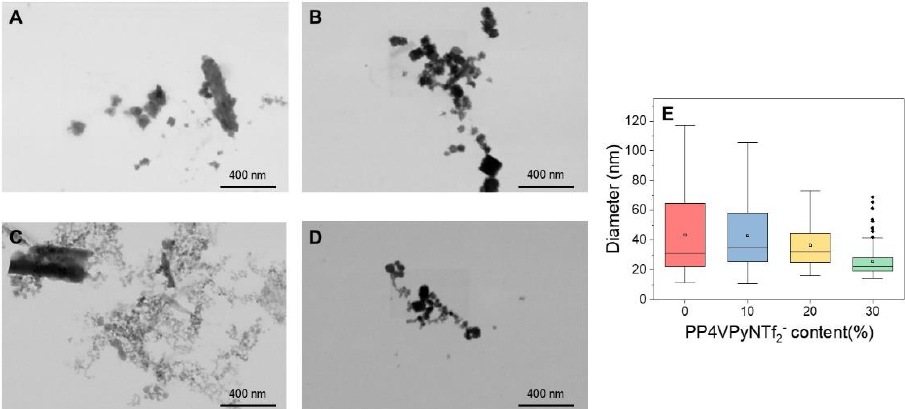
Figure 8. FE-SEM images of synthesized gold nanoparticles in ( A ) P4VPy, and P4VPy/PP4VPyNTf 2 − with ( B ) 10%, ( C ) 20%, ( D ) 30% of PIL, and size distribution of nanoparticles diameter ( E ).